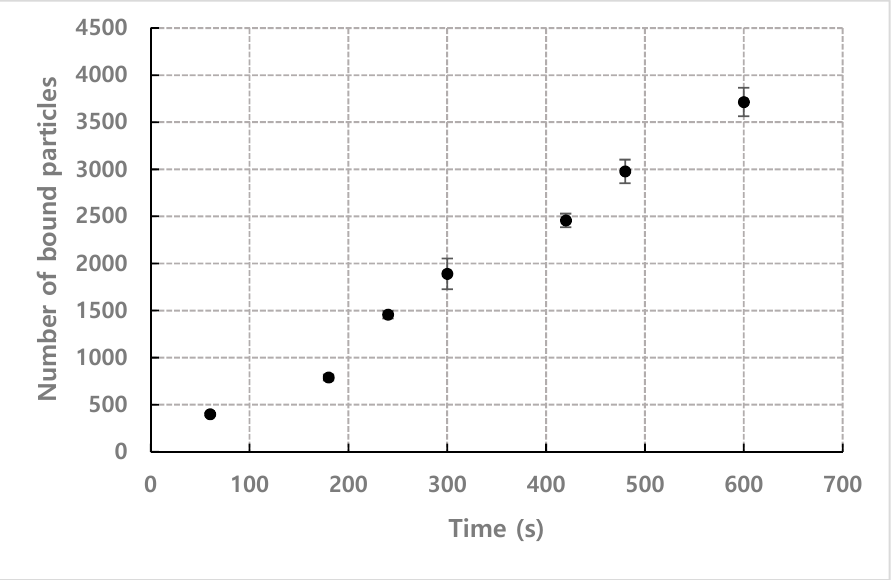
Figure 6. Result of measuring the number of bound particles according to the detection time ( n = 1.93 × 10 15 m − 3 , flow rate = 1.2 mL · h − 1 , observation position = 35 mm). Under the conditions of flow rate = 1.2 mL·h − 1 and observation position = 35 mm, Figure 7 shows the results of the number of bound particles normalized by number density n according to the detection time for each concentration. As shown in the graph, the normalized values approximate to a single linear curve.